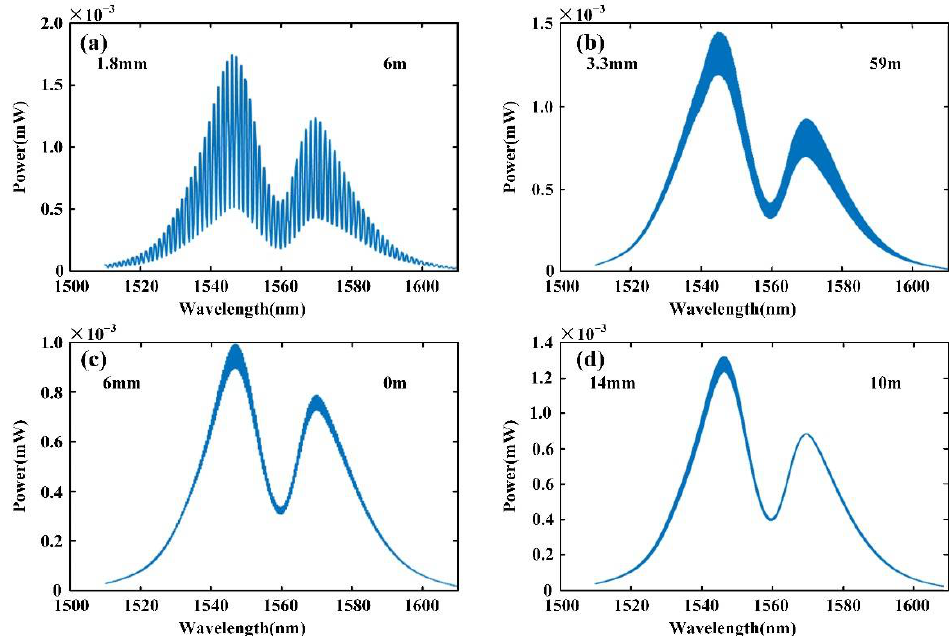
Figure 7. Spectrum of interference signal in experiment: ( a ) the interference spectrum at 1.8 mm; ( b ) the interference spectrum at 3.3 mm; ( c ) the interference spectrum at 6 mm; and ( d ) the interference spectrum at 14 mm.